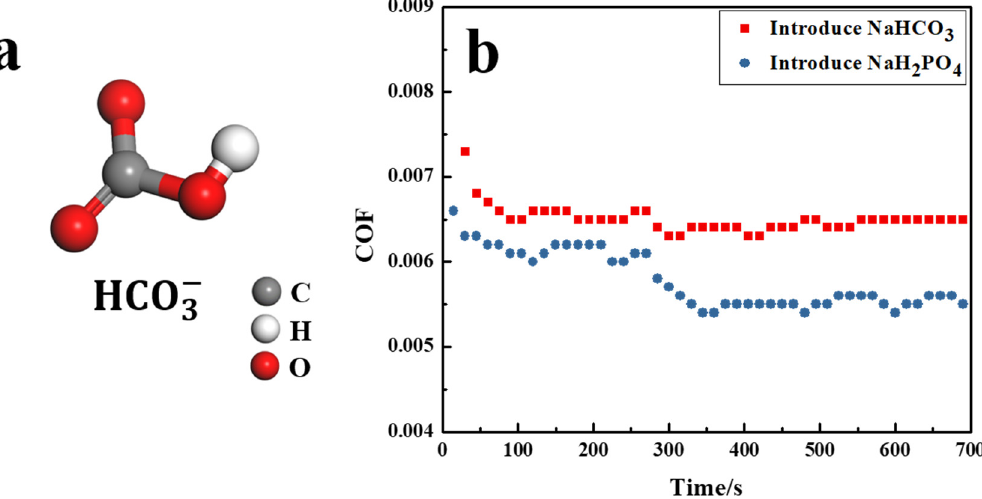
Figure 3. ( a ) Schematic diagram of the structure of HCO (cid:2871)(cid:2879) , ( b ) Variations in the COF of PVPA-modified Ti6Al4V in a NaCl solution sliding against PTFE balls induced by the introduction of anions with different structures.